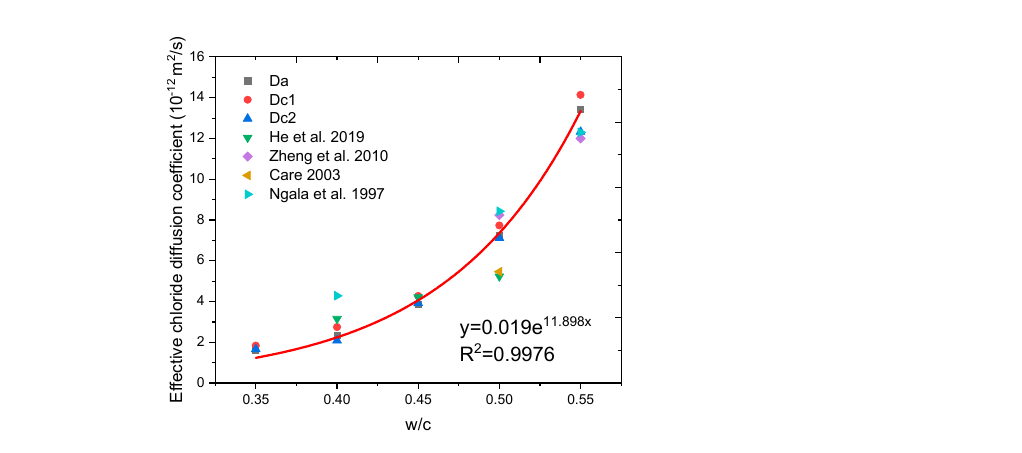
Figure 10. Comparison of effective chloride diffusion coefficient in this research with other re- searcher’s work.